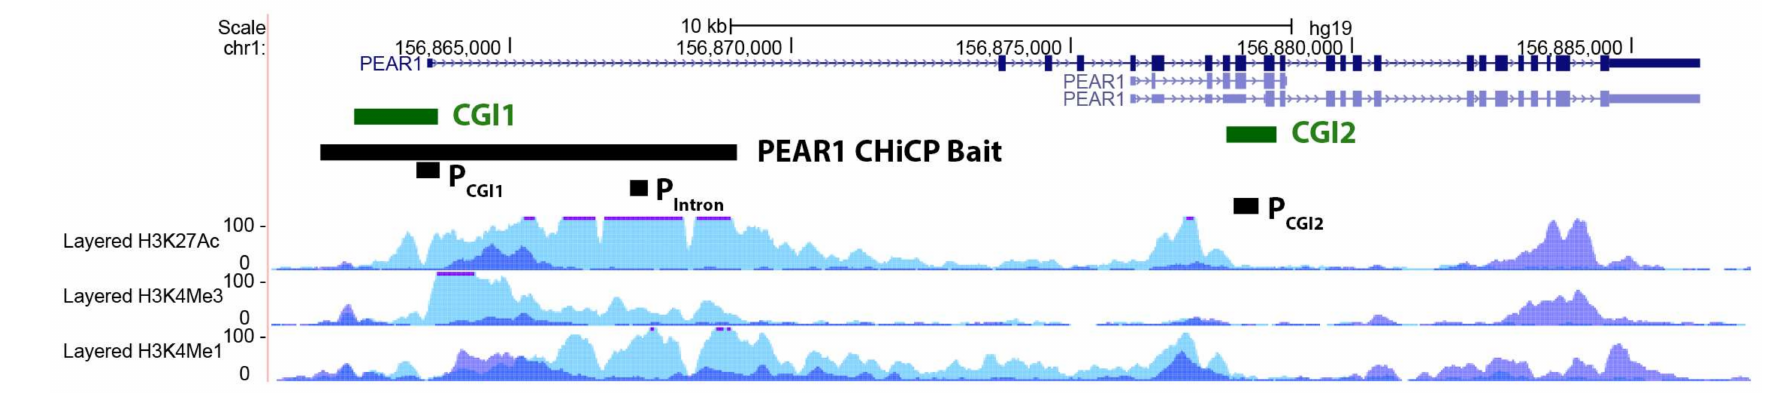
Figure 1. PEAR1 CHiCP bait overlaps with an enhancer region including PEAR1 CGI1 and intron 1. Exons are depicted as black boxes, introns as black lines. P CGI1 , P intron and P CGI2 indicate the regions analysed in the methylation study as described in material and methods and [53]. PEAR1 bait of 7.48 Kb (chr1:156,861,611–156,869,031) identified in the CHiCP analysis is represented as black box. Human Umbilical Vein Endothelial Cells (HUVECs) and K562 H3K4Me1, H3K4Me3 and H3K27Ac profiles are displayed as coloured overlaid histograms (light blue for HUVECs, purple for K562) in “auto-scale to data view” mode that takes the highest signal in the selected region as the 100% of the intensity and display all other signals accordingly (data produced by the Bernstein Lab at the Broad Institute and the UCSC and part of the ENCODE database). PEAR1 CHiCP bait overlaps with high deposition of the enhancer specific histone marker H3K4Me1 and the promoter specific H3K4Me3. High peaks of the open active chromatin specific histone mark H3K27Ac are also visible in the same region. Adapted from UCSC